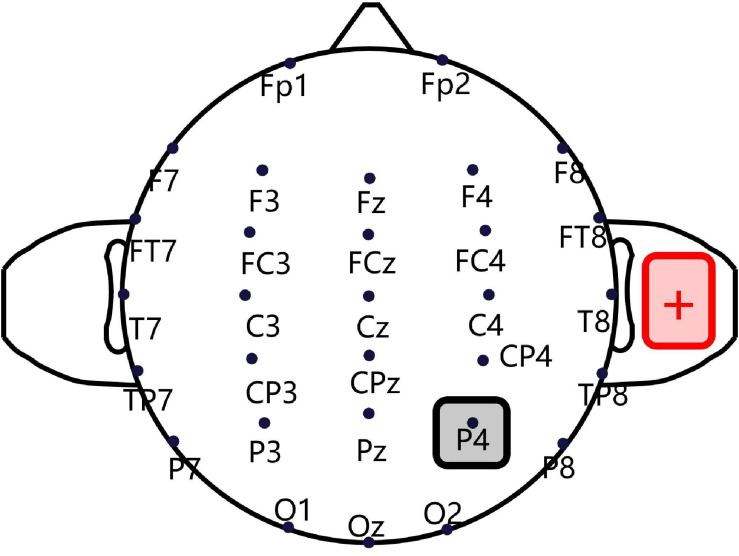
Transcranial direct current stimulation montage. Saline-soaked cathodal sponge electrodes (5 cm × 5 cm) were applied over the right P4 region, according to the International 10/20 electroencephalogram (EEG) system, and a larger anodal electrode (5 cm × 7 cm) was placed on the right shoulder deltoideus triangularis.